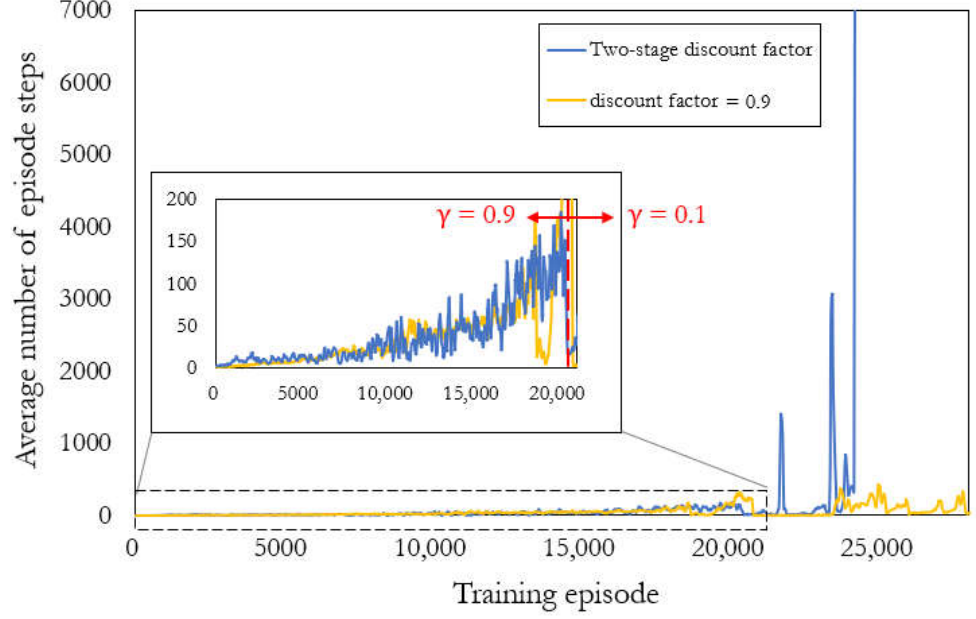
Figure 4. Average number of steps for the last 100 training episodes with the two-stage discount factor (blue) and discount factor = 0.9 (yellow), where γ is the discount factor.